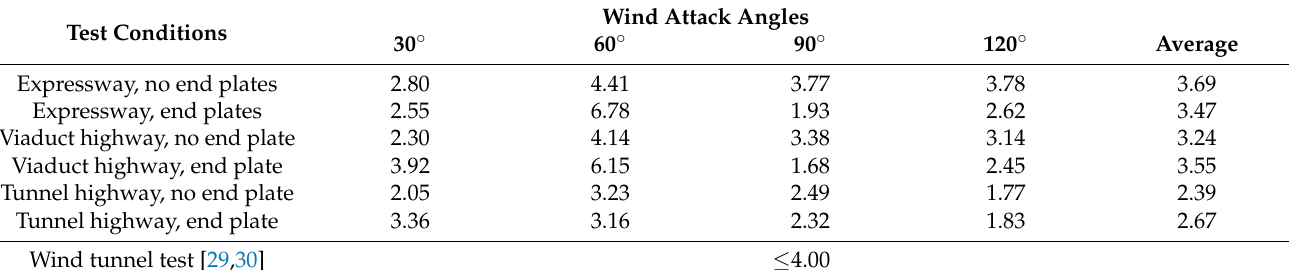
Table 4. Measured coefficient of variation of vehicle-driving wind speed (%).